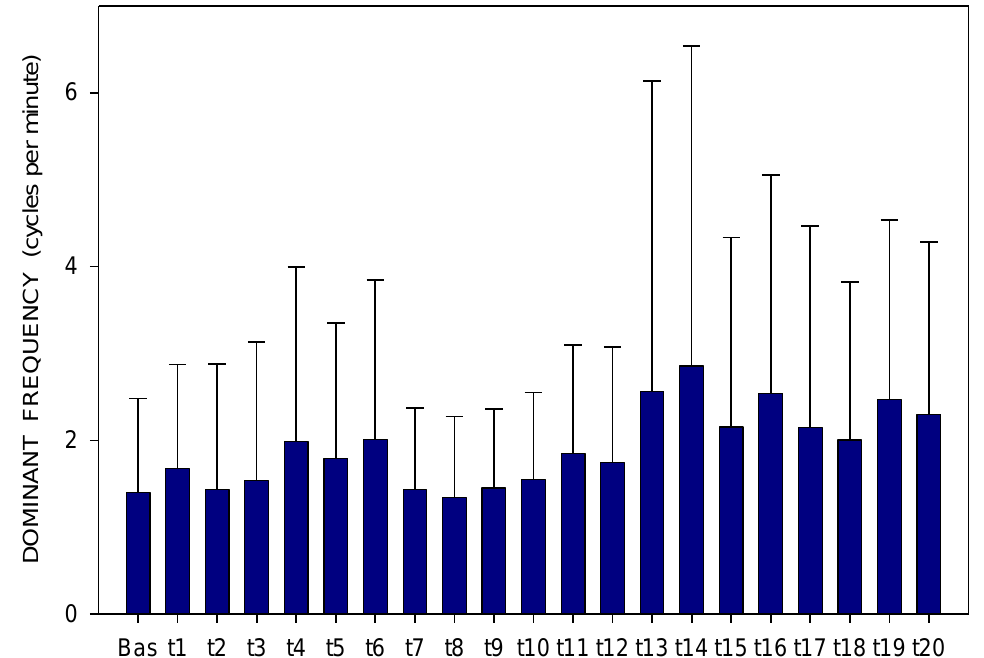
Figure 1. Electrogastrography. Dominant frequency before and after a single intragastric dose of 24 mg galantamine (mean + standard deviation). Explanatory note: Bas: 15-min basal recording before galantamine administration; tn: 15-min study recordings after galantamine administration (t1: time interval between 0–15 min...t20: time interval between 286–300 min).